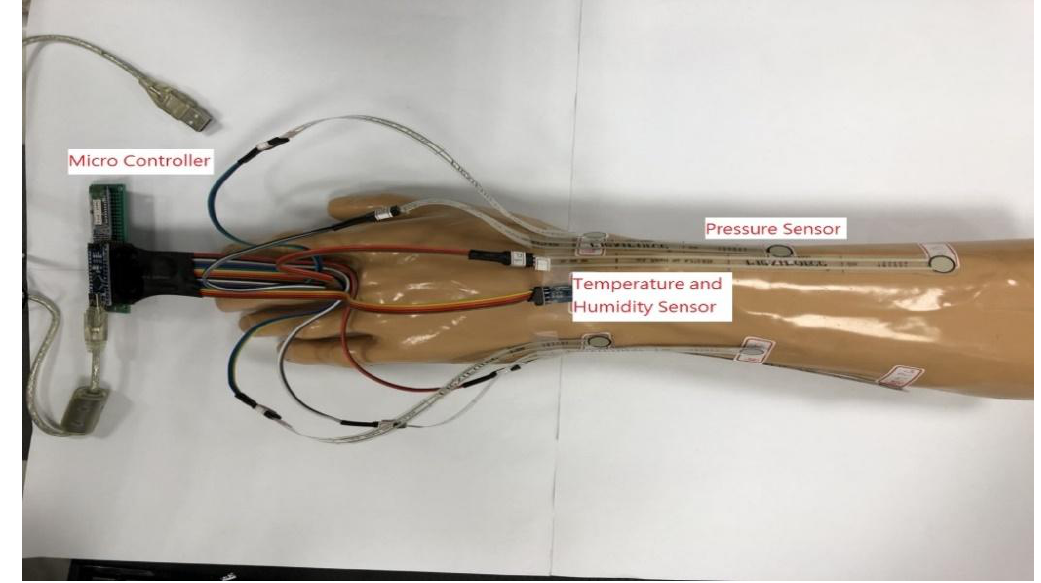
Figure 3. Location map of pressure, temperature, and humidity detection point on a simulated arm.